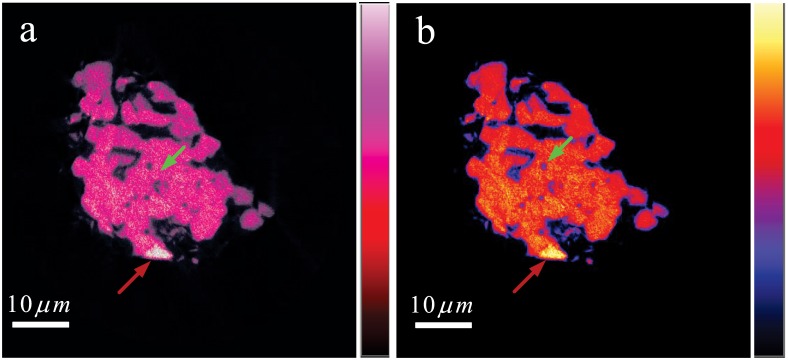
The false color map of the typical slice in Fig 9i.